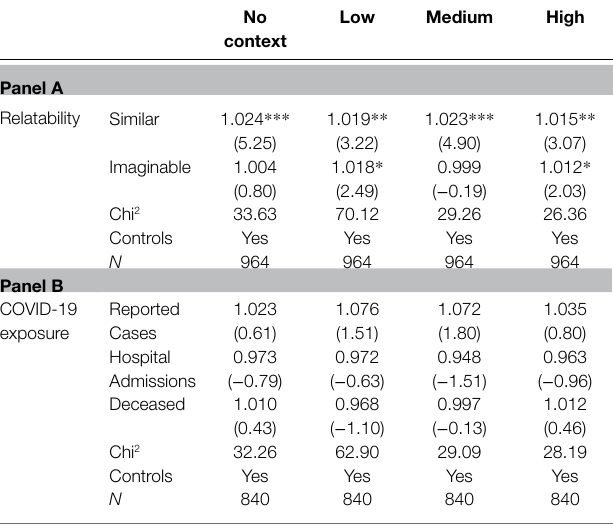
TABLE 5 | Logit regressions: respondent characteristics and decision to go. Marginal effects resulting from logit regressions